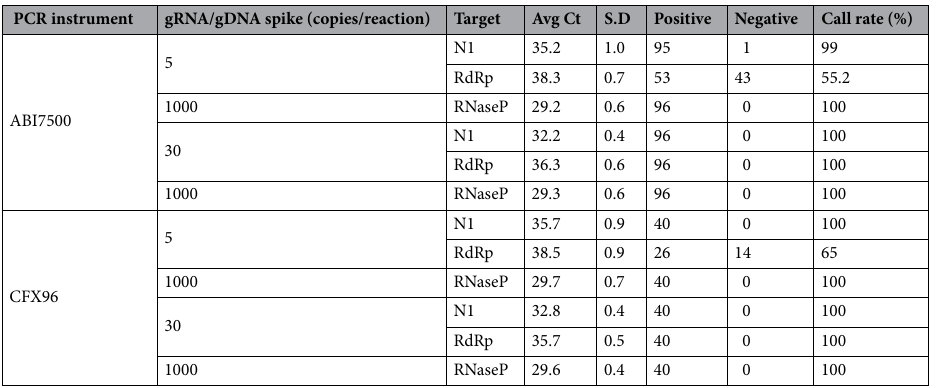
Table 1. LoD confirmation of analytical sensitivity of EM RT-PCR assay. Each copy level was comprised of either 96 replicates (ABI7500) or 40 replicates (CFX96) at either 5 copies SARS-CoV-2 gRNA/reaction or 30 copies SARS-CoV-2 gRNA/reaction. Each reaction also contained 1000 copies of human gDNA (RNaseP) as an inhibitor